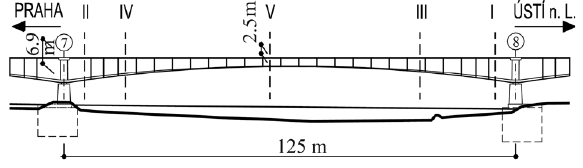
fig. 1. Instrumented sections in the main span of the bridge